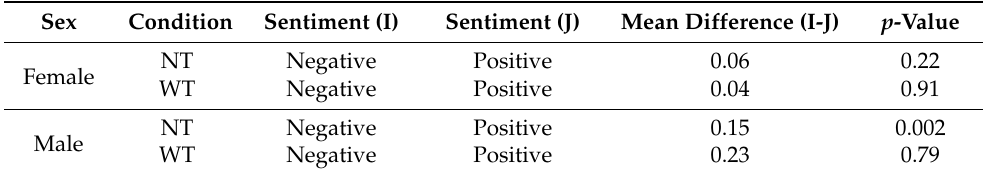
Table 5. Sex Comparison Between Physiological Arousal Change in Positive and Negative Utterances by Touch Condition.